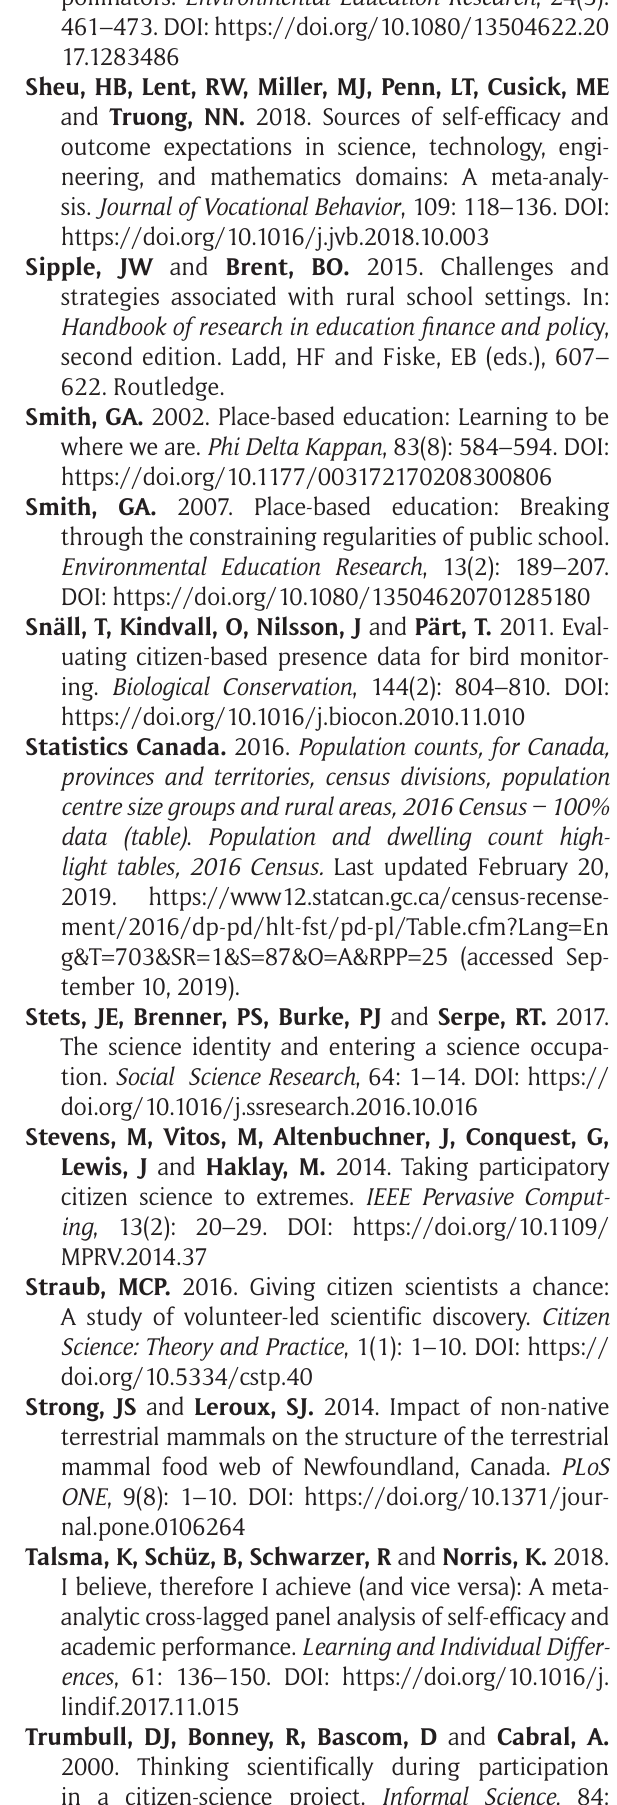
data (table) . Population and dwelling count high- light tables, 2016 Census. Last updated February 20,